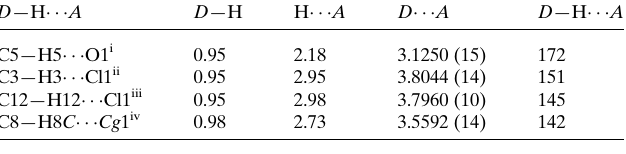
Table 2 Hydrogen-bond geometry (A˚ , (cid:4) ) for (II).